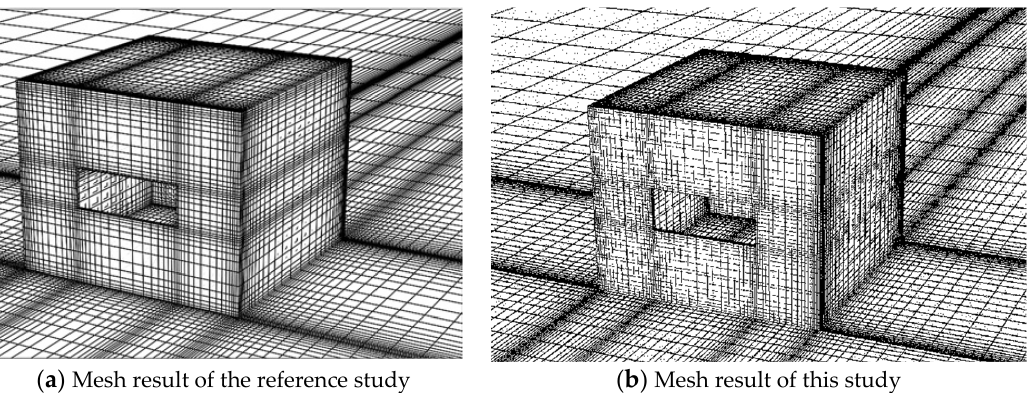
Figure 8. Perspective view of the grid at building surfaces and ground surface: ( a ) mesh result of the reference study; and ( b ) mesh result of this study.